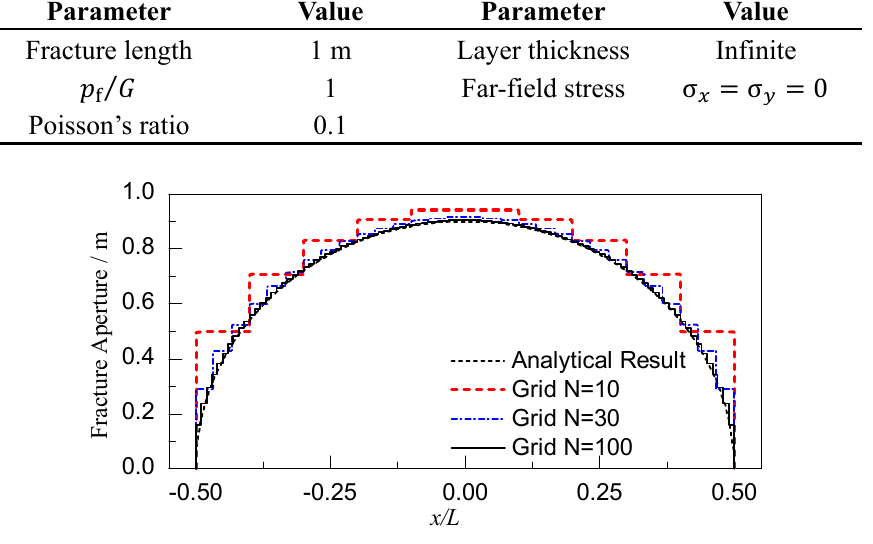
Table 1. Input parameters for the calculation of fracture aperture profile. Parameter